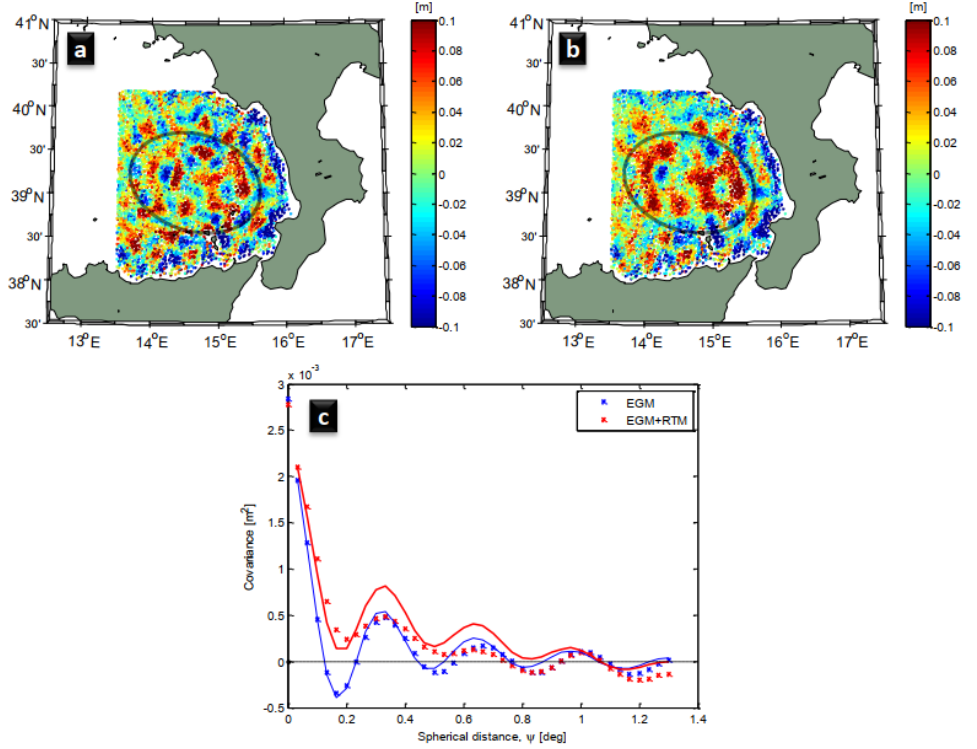
Fig. 2. Residual height anomaly from RADS dataset after cross-over adjustment (a) for only removing the EGM2008 (d/o 1080) (b) for re- moving the EGM2008 (d/o 1080) and also RTM effects (c) empirical covariance (* symbols) and Tscherning&Rapp covariance model fitting (curved lines). The blue curves refers to (a) while the red curves refers to (b). The area bounded by ellipse has deep and flat bathymetry.